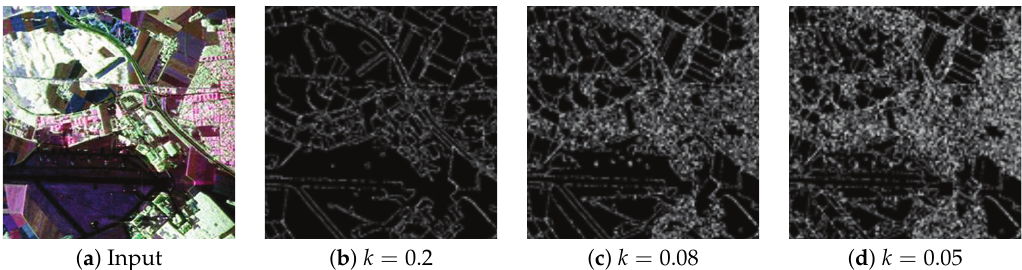
Figure 3. Multiscale segmentation under three different thresholds. ( a ) The input SAR image; ( b – d ) the segmentation results by adjusting the threshold k . The lower the threshold is set, the more sub-regions are